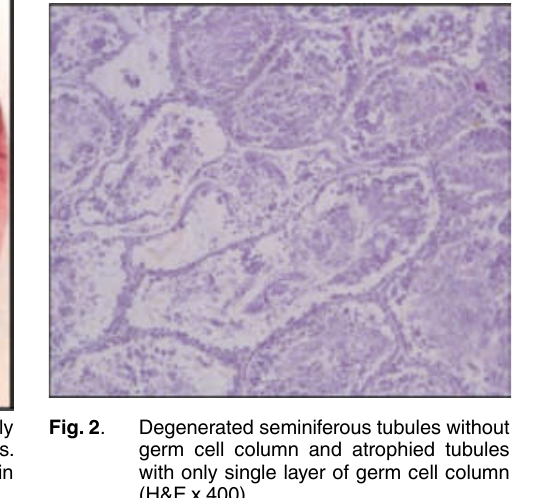
Fig. 2 . Degenerated seminiferous tubules without germ cell column and atrophied tubules with only single layer of germ cell column (H&E x 400)